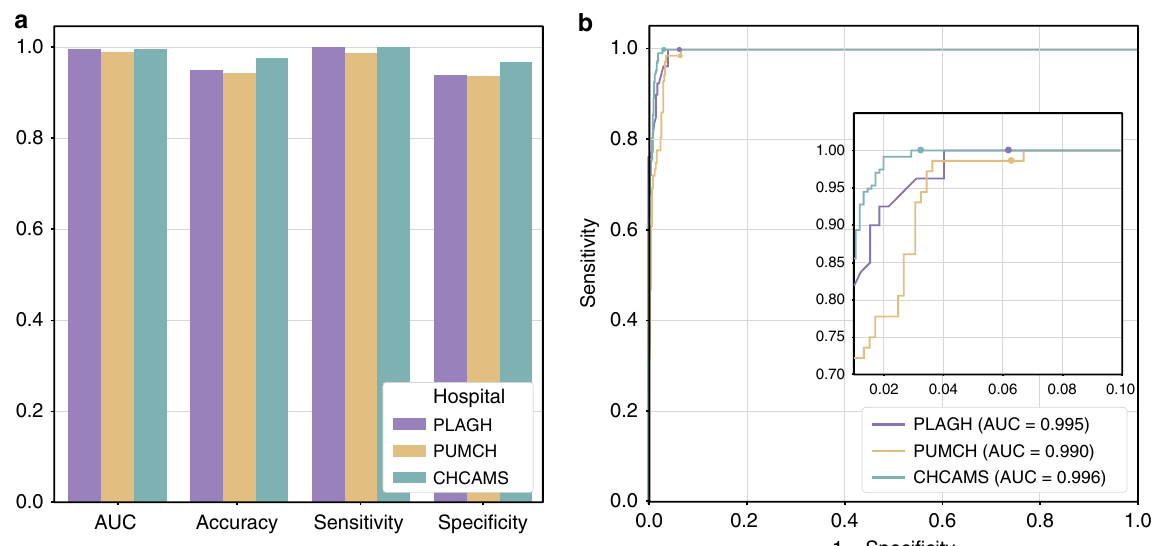
Fig. 4 Model performance on the multicentre dataset. a The AUC, accuracy, sensitivity, speci fi city of the deep learning model on data collected from three hospitals. b ROC curves of the model on the multicentre